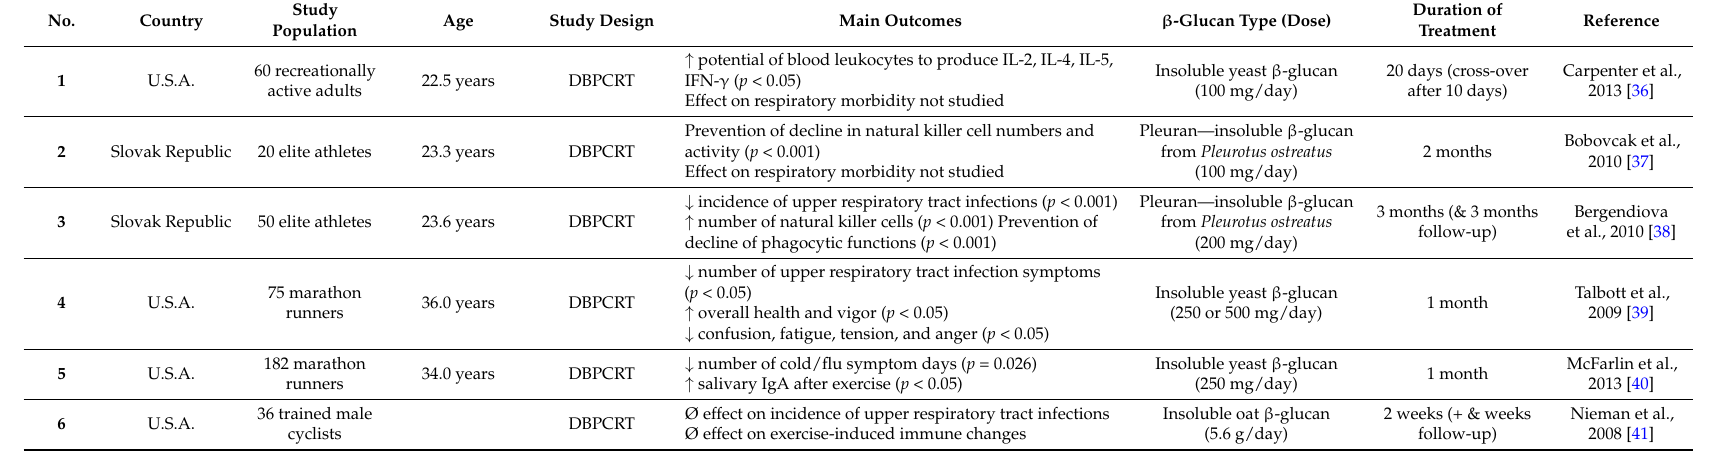
Table 2. Effect of β -glucans of different origin on respiratory tract infections and laboratory parameters in